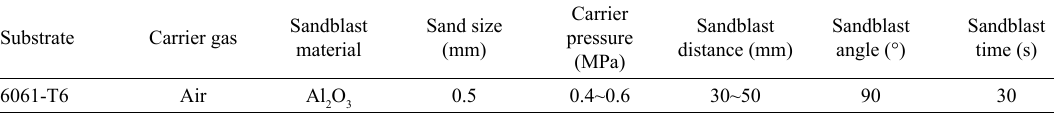
Table 4. Related sand blast parameters before arc spraying process.